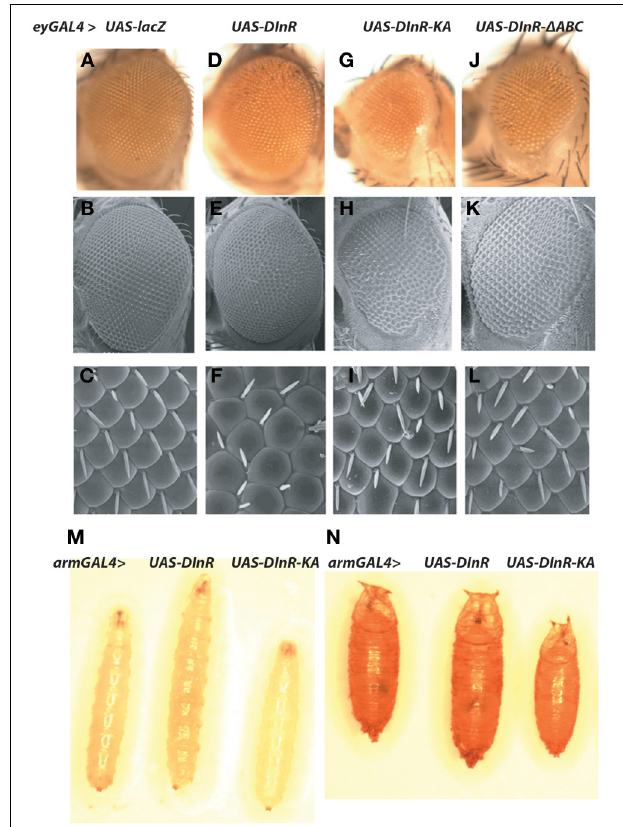
FIGURE 3 | Effects of ectopic expression of DInR on tissue-specific and whole animal growth. Effects of ectopic expression of full-length Myc-tagged DInR or variants was tested using the UAS/GAL4 system. (A–L) Expression driven by an eyeless-GAL4 driver. (A–C) Control, UAS-lacZ ; (D–F) UAS-DInR ; (G–I) UAS-DInR-KA ; (J–L) UAS-DInR- (cid:2) ABC. Top row (A,D,G,J) , photographs of eyes with light microscopy. Note that expression of DInR results in increased eye volume such that the eyes now have increased depth. These eyes project out from the 2D image, occupying a larger 3D space. Middle row (B,E,H,K) , SEM. Bottom row (C,F,I,L) , high power SEM images show rough eyes induced by ectopic DInR expression. (M,N) Moderate expression using an arm-GAL4 driver. (M) Third instar larvae: control, UAS-DInR , UAS-DInR-KA ; (N) pupae: control, UAS-DInR , UAS-DInR-KA